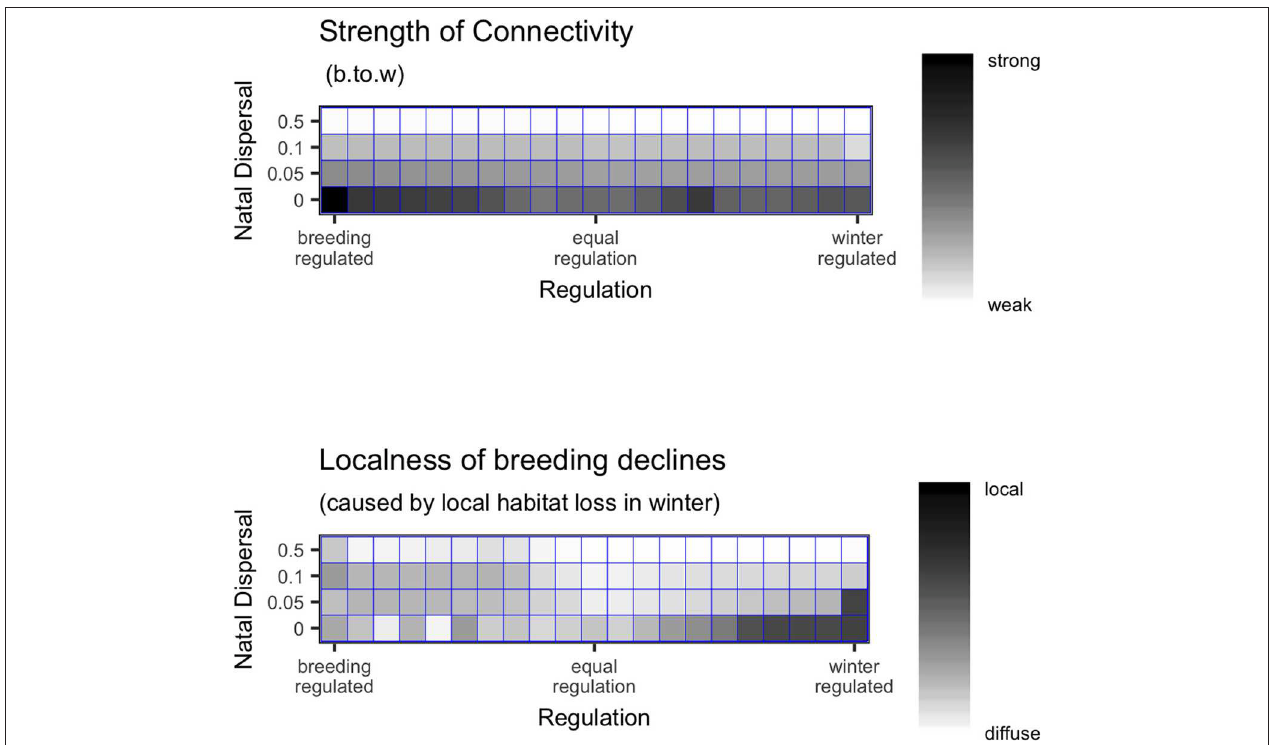
FIGURE 4 | Top panel shows the breeding-to-winter (b.to.w; NMC BW ; Equation 1) connectivity, and bottom panel shows the localness (as defined in text) of declines, as they vary with natal dispersal, ND and regulation . The lack of correspondence between the top and bottom panels shows that connectivity is not a reliable predictor of